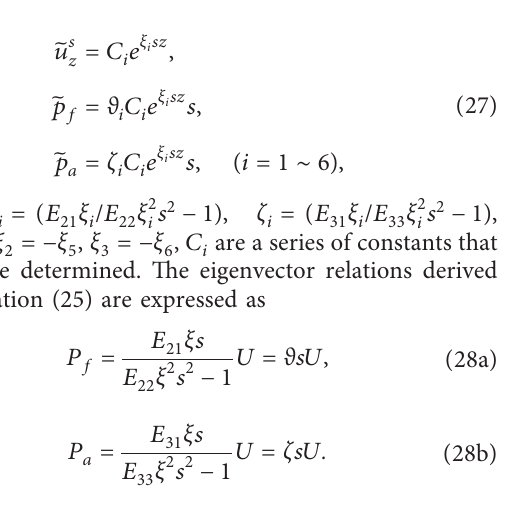
Figure 2: Schematic of a one-dimensional unsaturated soil column under dynamic